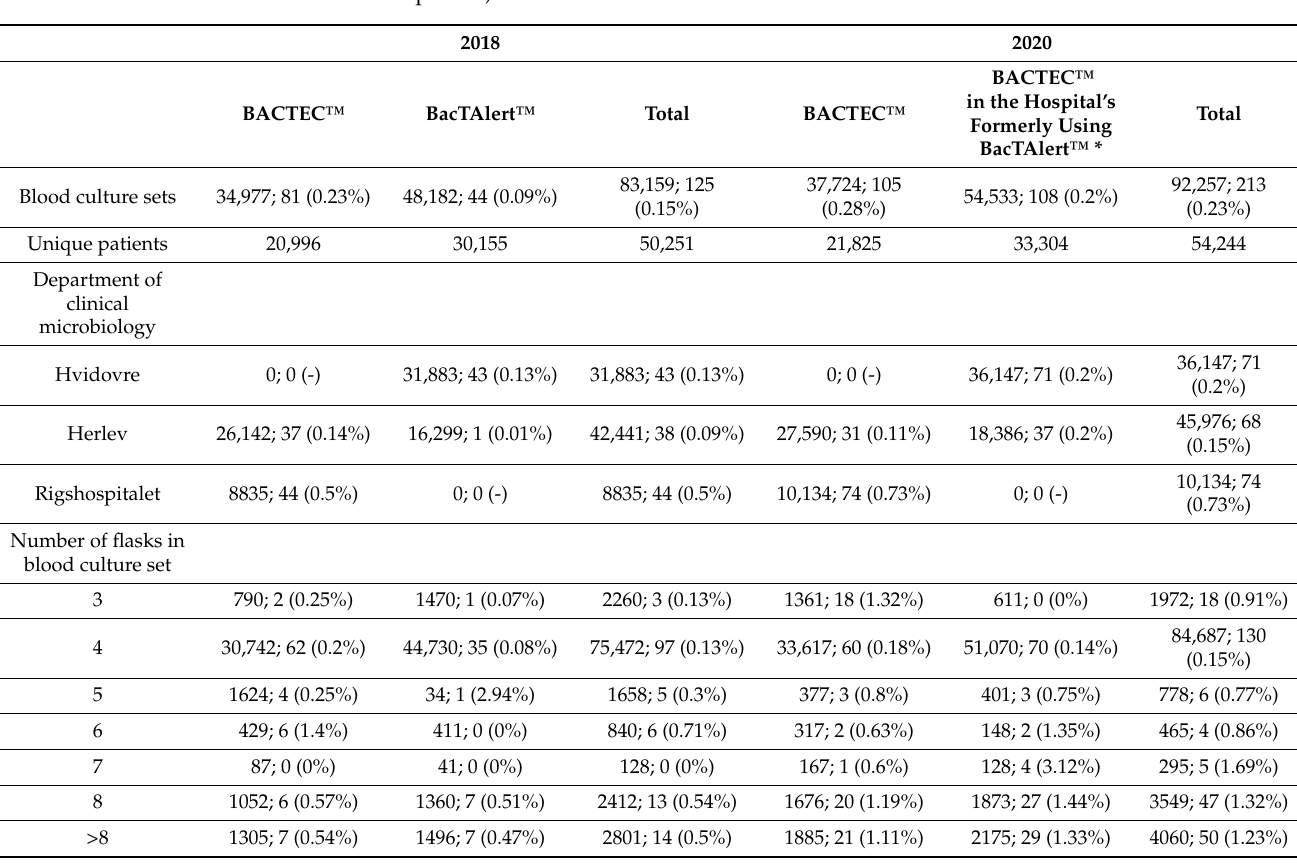
Table 2. Characteristics blood culture sets ( ≥ 3 blood culture flasks taken no more than 3 h apart from the same